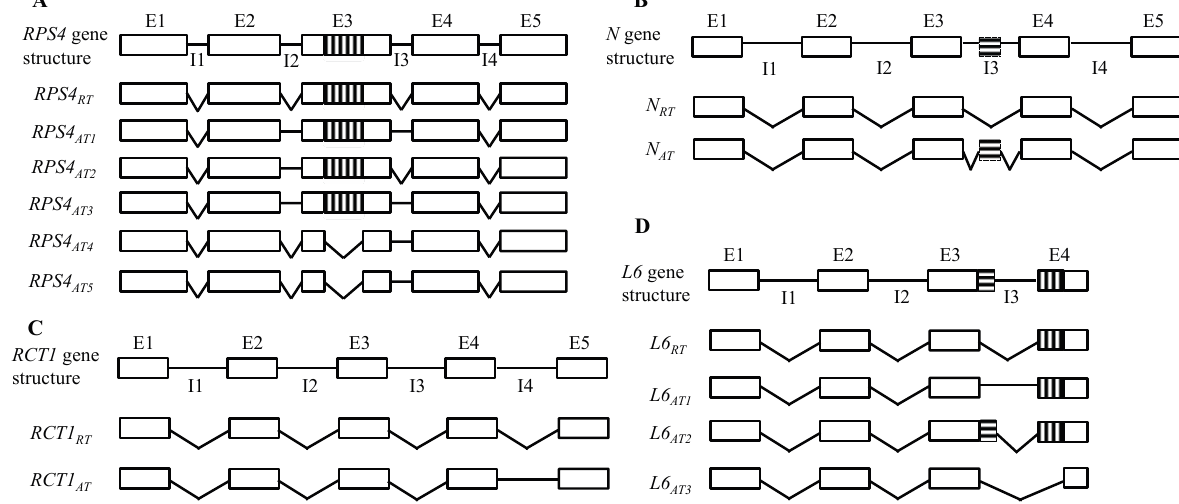
Figure 1. Schematic diagramof gene structure and transcript isoforms for the TIR-NBS-LRR genes Arabidopsis RPS4 ( A ); tobacco N ( B ); M. truncatula RCT1 ( C ); and flax L6 ( D ). Exons are shown as boxes. The cryptic introns are indicated by vertically hatched boxes in the exons, and horizontally hatched boxes for cryptic exons in introns. The spliced and retained introns are shown as angled and straight lines, respectively. RT, regular transcript encoding the full-length protein product; AT, alternative transcript encoding an aberrant protein product; E, exon; I,